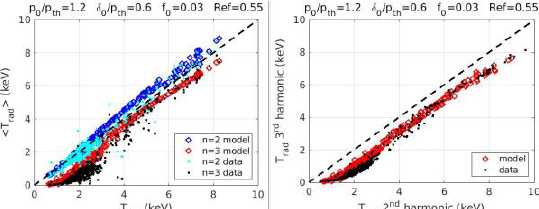
Fig. 8. As in Fig. 7, for the DT baseline scenario discharges data set (pulse numbers: 99520, 99795, 99796, 99797, 99799, 99805, 99861, 99862, 99863, 99878, 99943, 99944, 99948). Perturbation parameters: f 0 = 0.03, p 0 /p th = 1.2,  /p th = 0.6.